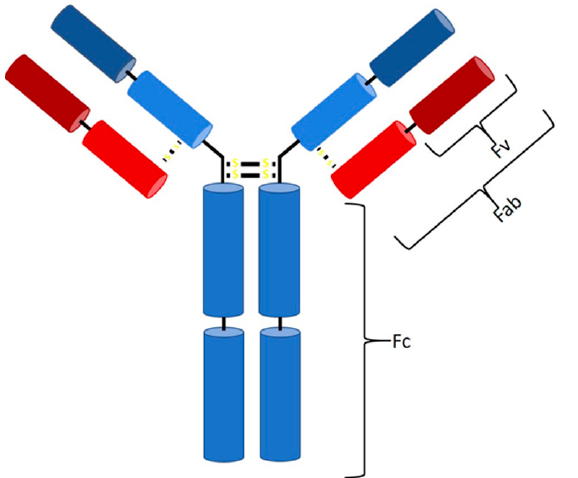
Figure 1. Structure of an IgG antibody. The Fc binding region consists of four heavy chains (2× C H 3, 2× C H 2), and the Fab region consists of one constant heavy and one constant light chain, while, at the top, two variable chains of each type are located (Fv region).